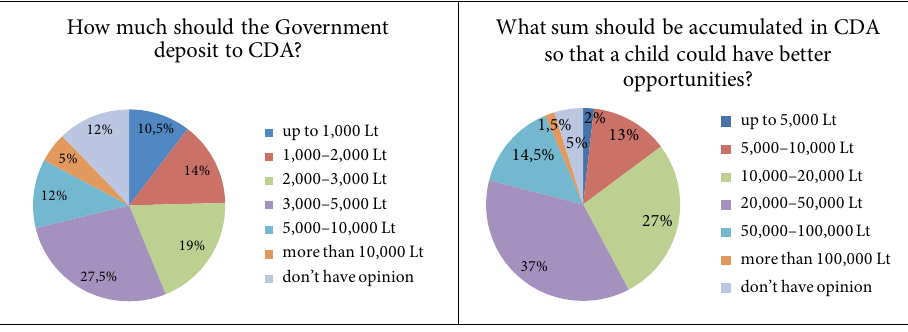
Fig. 8. Respondents’ opinion towards amount of Government’s initial deposit and the accumulated sum after 18 years (authorial computation, according to the survey data)